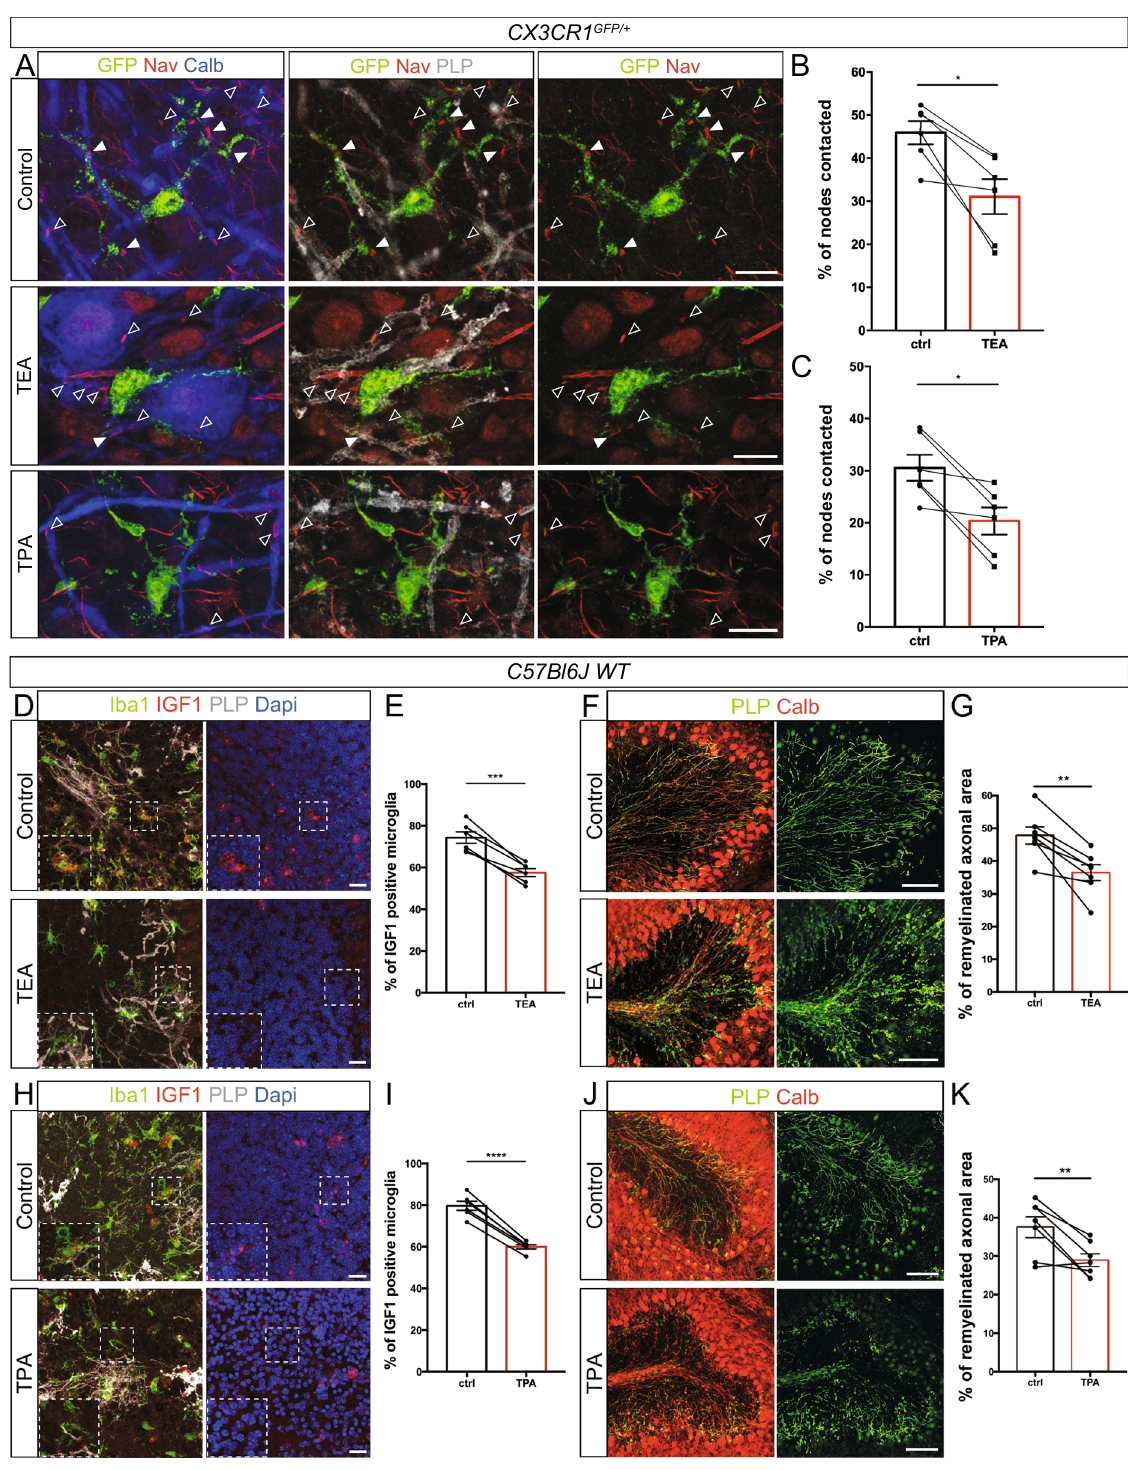
main channel implicated in microglial K + conductance 10 . Interestingly, THIK-1 channel is expressed in microglial cells in the CNS in healthy as well as MS tissues 55,68 . These different pharmacological approaches affect the microglial switch towards a pro-regenerative pro fi le, associated with decreased remyelina- tion. This suggests that neuron dialog with microglia through K + signaling might in fl uence myelin regeneration